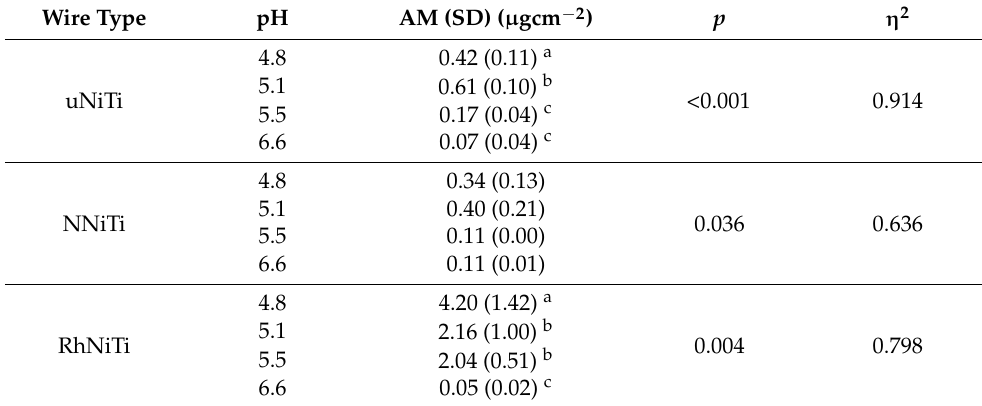
Table 2. Distribution of the cumulative Ti-ions release in relation to the pH of artificial saliva and the wire